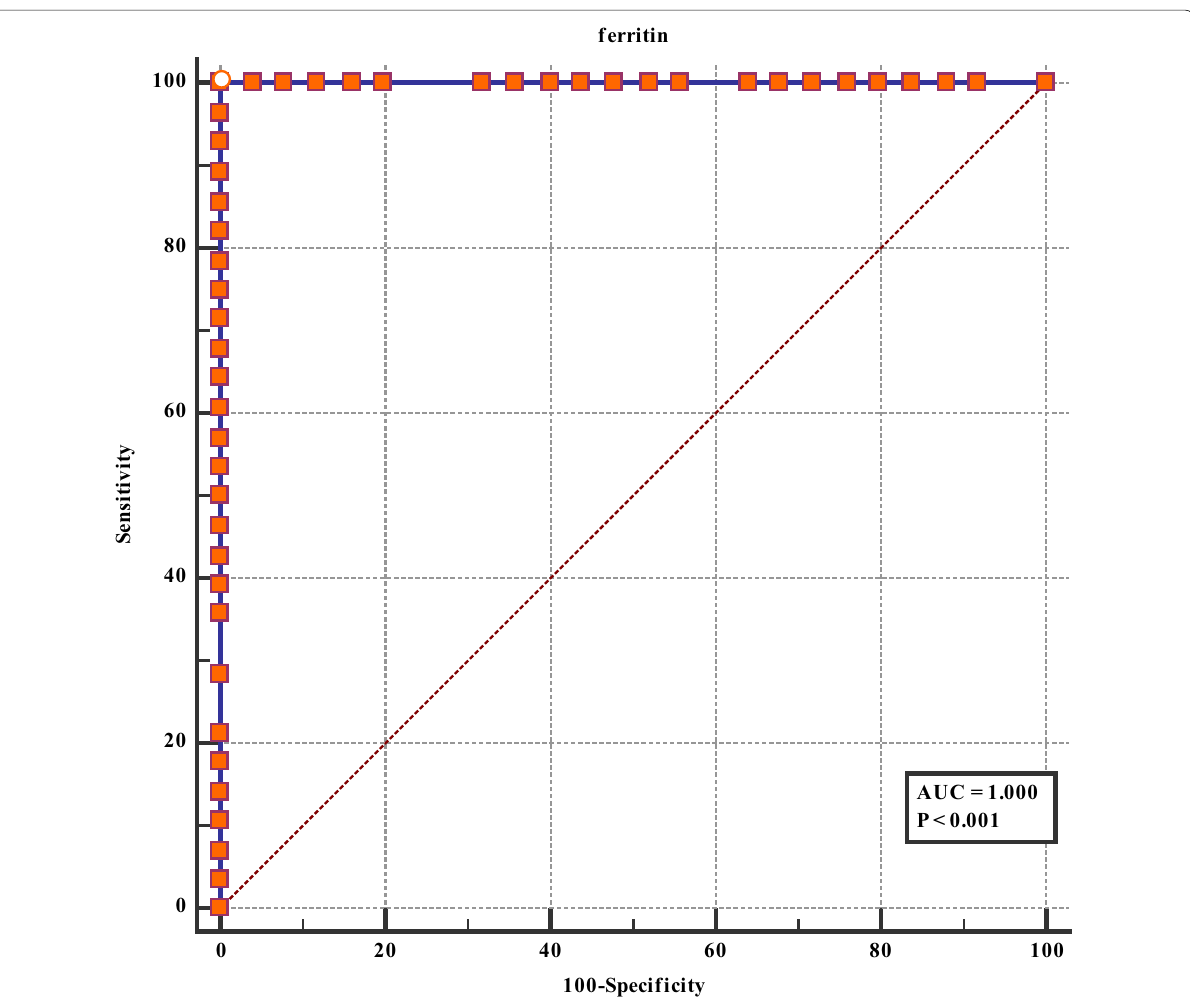
Fig. 2 Receiver operating characteristic curve for prediction of significant fibrosis (Fibroscan, F 2, 3, 4) from ferritin